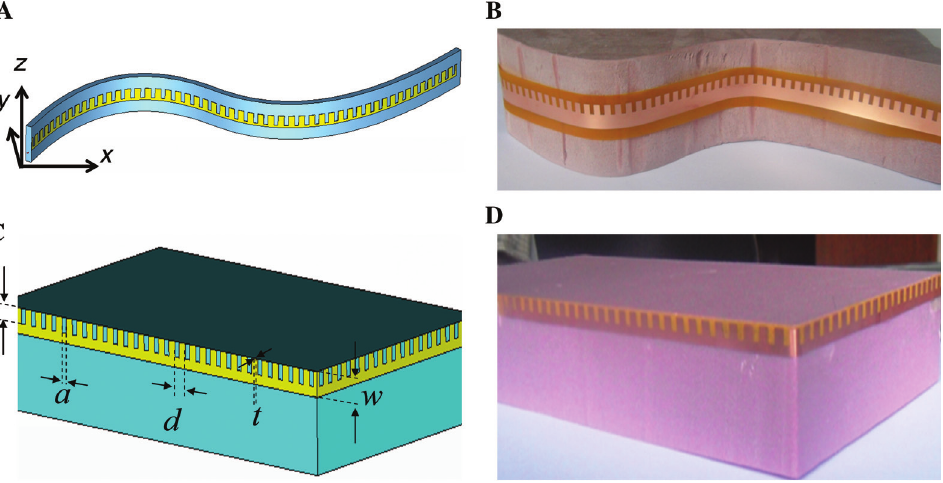
Figure 11: (A) and (B) Designed model and fabricated sample of smooth (S-bending) curved surface. (C, D) Designed model and fabricated sample of non-smooth (cubical) surface. Here, a = 2 mm, d = 5 mm, h = 4 mm, w = 5 mm, and t = 0.018 mm.